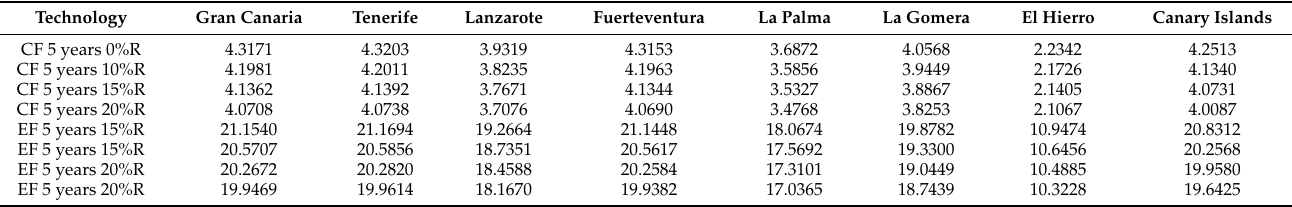
Table 17. Carbon Footprint (CF) and Ecological Footprint (EF) for highest energy consumption case in the Canary Islands. Year 2017.